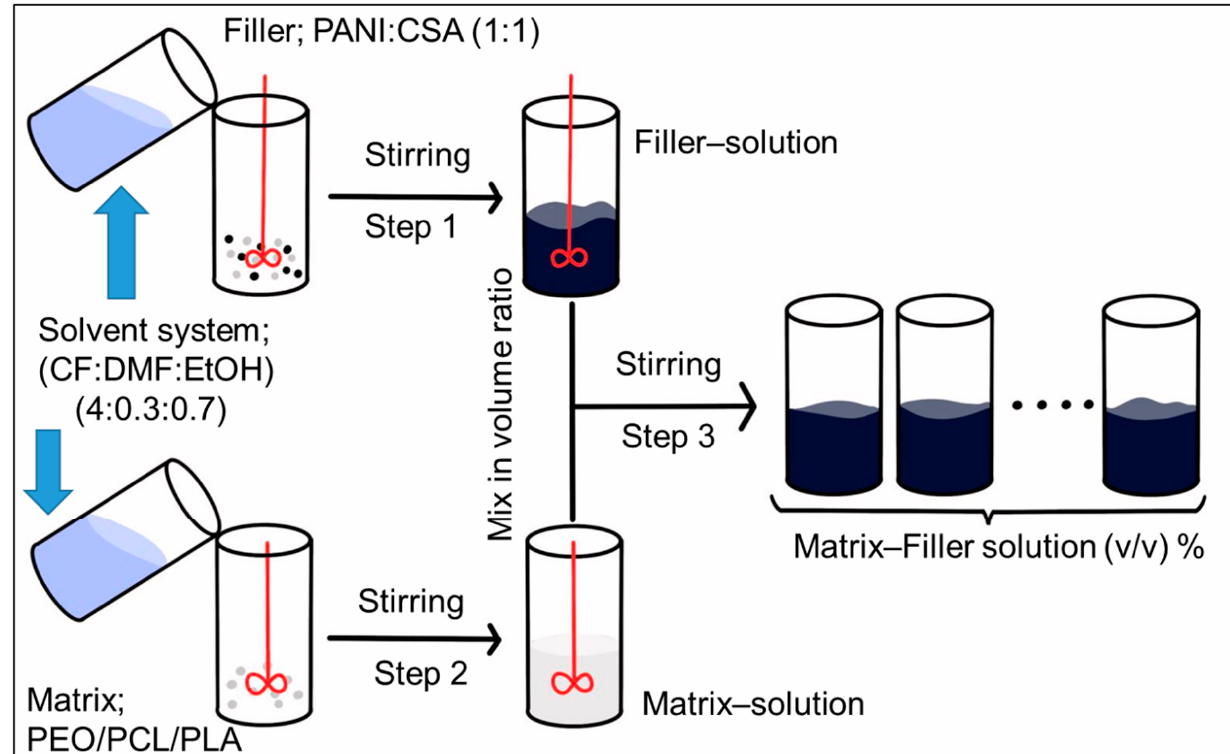
Figure 12. Schematic representation of the procedure for the preparation of spinning